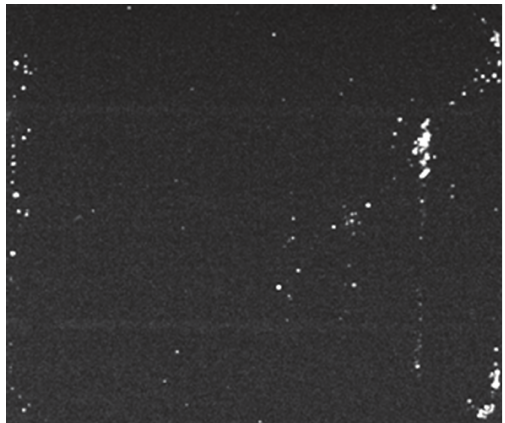
Figure 8: Microplasma method-scanning time 20 s, reverse voltage 4.0V, current 0.15A, sample no.